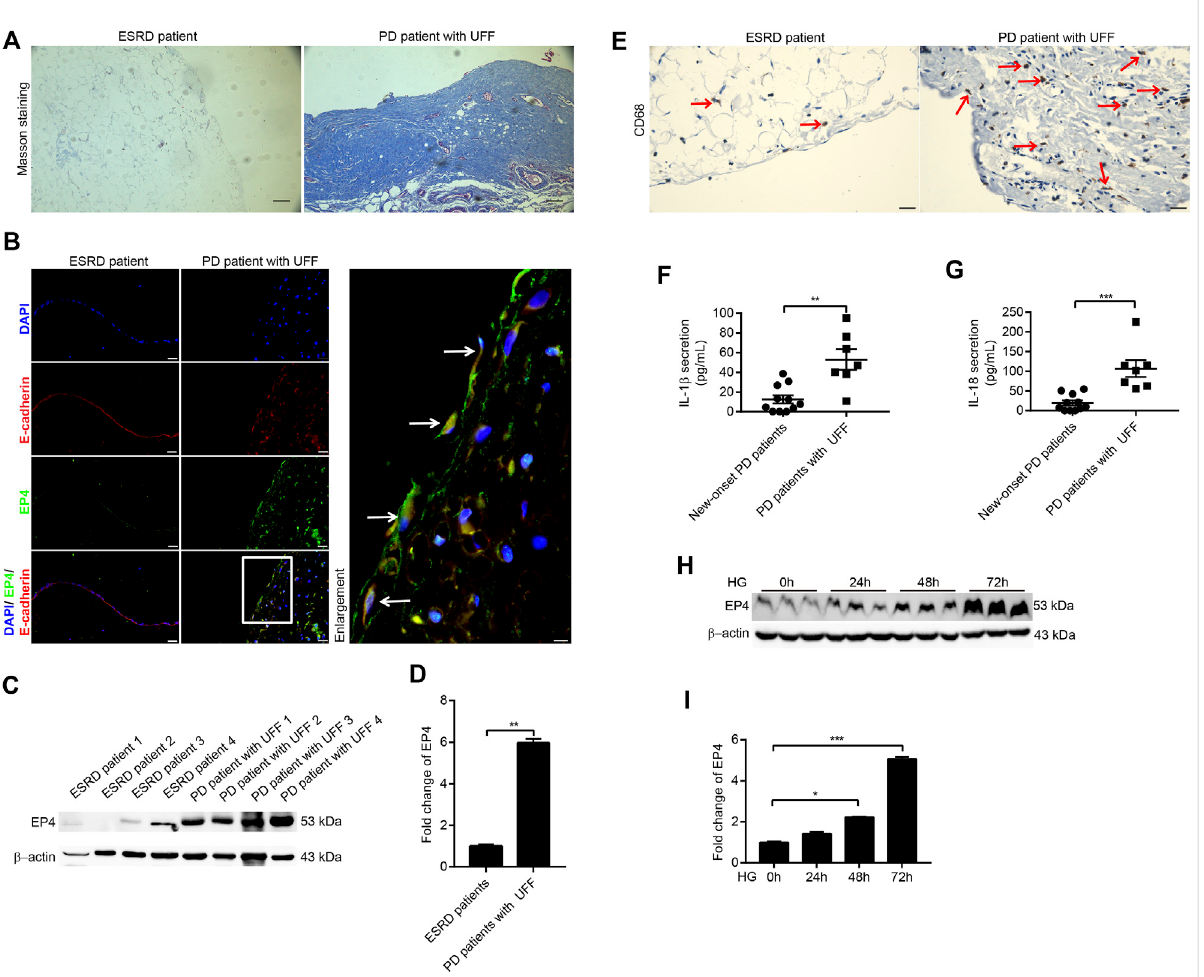
FIGURE 1 Expression of EP4 increased during peritoneal fi brosis in patients with UFF and high-glucose – induced RPMCs. (A) Masson staining from peritoneal tissues of ESRD patient and PD patient with UFF. Scale bar = 100 μ m. (B) Immuno fl uorescence microscopy of peritoneal tissue sections stained for EP4 (green) and E-cadherin (red) with DAPI (blue). Arrows represent EP4- and E-cadherin – positive mesothelial cells. Scale bar = 25 μ m. (C) Peritoneal tissue lysates from ESRD patients and PD patients with UFF were subjected to western blotting analysis with speci fi c antibodies against EP4 and β -actin. (D) EP4 expression levels were quanti fi ed by densitometry, normalised with β -actin, and presented as fold changes. (E) Immunohistochemistry analysis of peritoneal tissue sections stained for CD68. Arrows represent CD68-positive cells. Scale bar = 25 μ m. (F,G) Dialysates from new-onset PD patients ( n = 11) and PD patients with UFF ( n = 7) were subjected to ELISA analysis to detect secretion of IL-1 β (F) and IL-18 (G) . (H) Cell lysates from RPMCs exposed to 138 mmol/L glucose at different times were subjected to western blotting analysis with speci fi c antibodies against EP4 and β -actin. (I) EP4 expression levels were quanti fi ed by densitometry, normalised with β -actin, and presented as fold changes. Data are presented as mean ± SEM. * p < 0.05, ** p < 0.01, *** p <